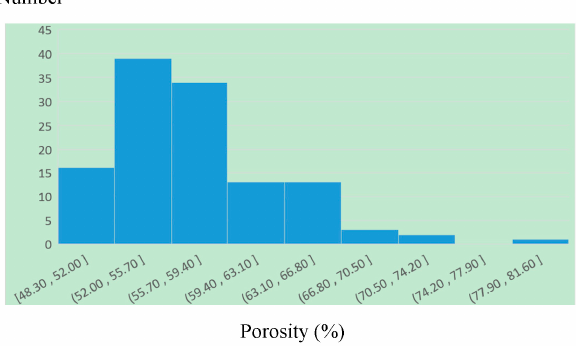
Figure 10. Histogram of fine sediment porosity.